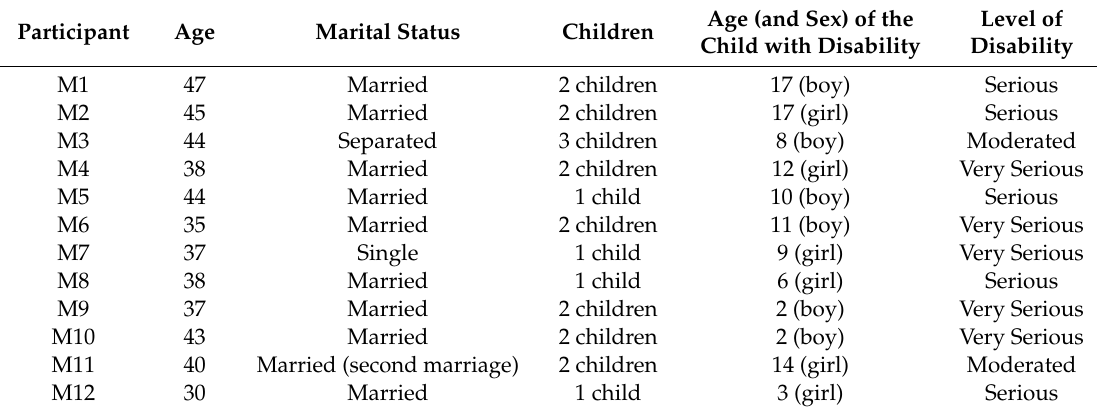
Table 1. Characteristics of